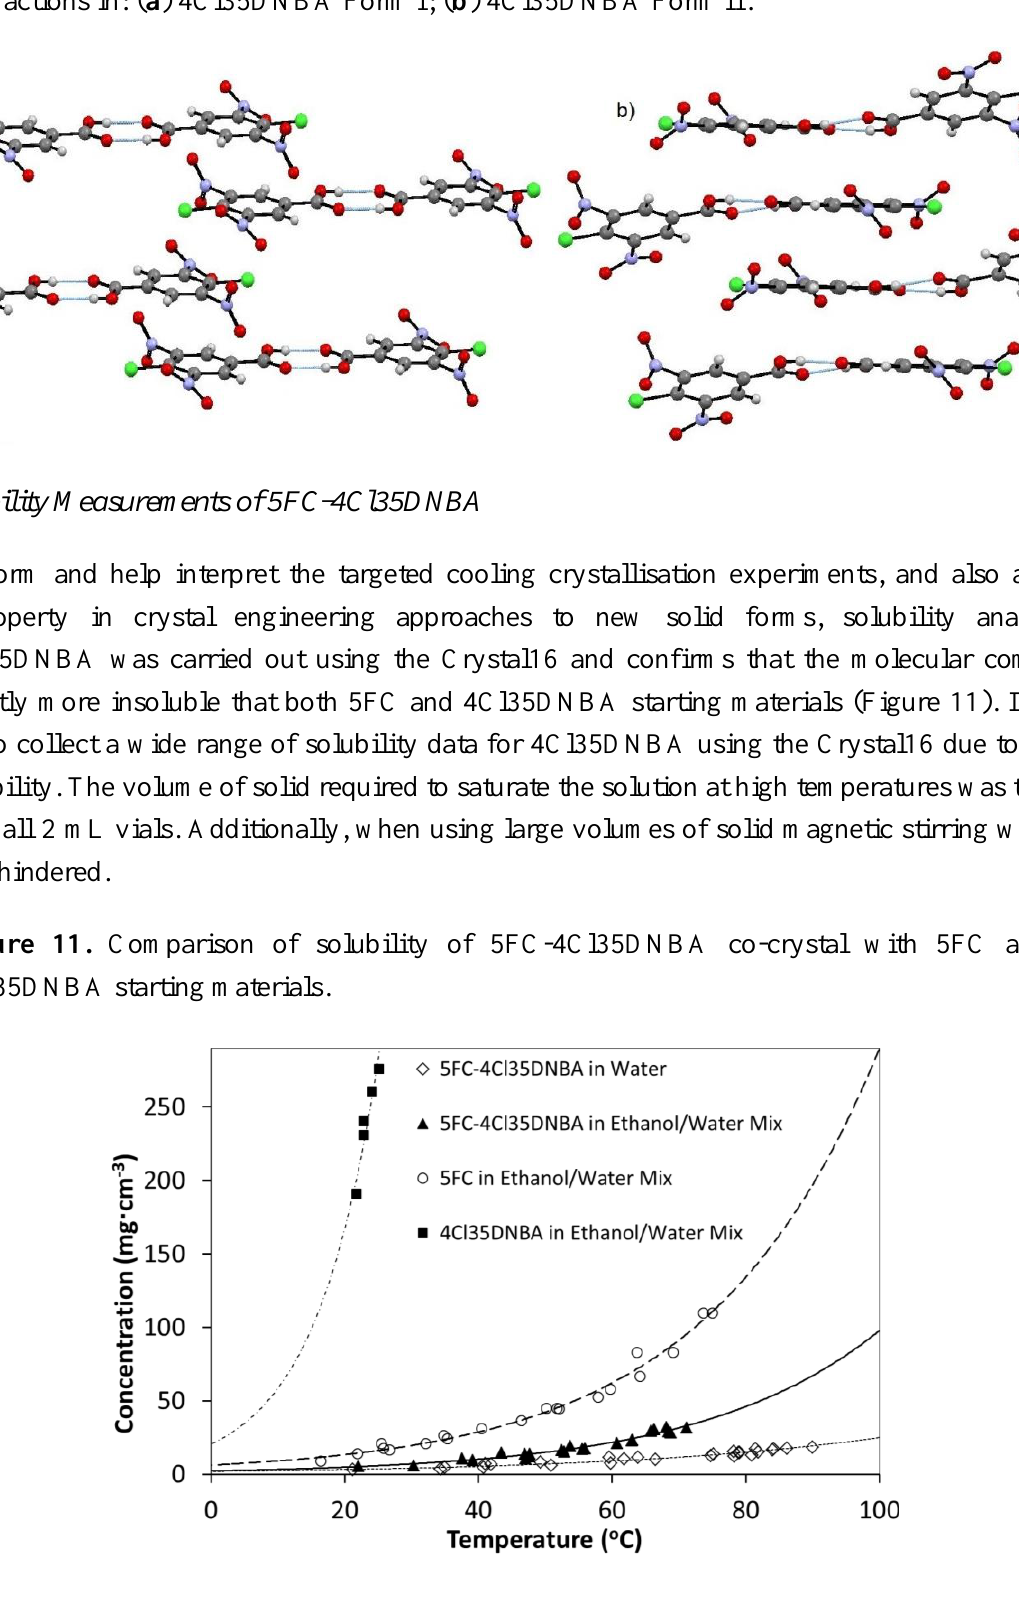
Figure 10. 4Cl35DNBA dimers packing into layered sheets through  –  stacking interactions in: ( a ) 4Cl35DNBA Form I; ( b ) 4Cl35DNBA Form II.